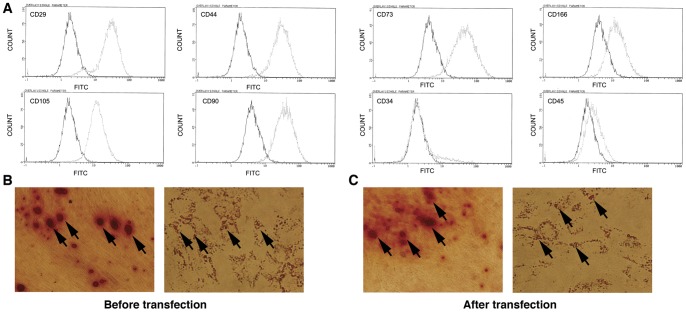
Analyze of the purified hpMSCs population.A. The phenotype characteristics of purified MSCs were verified by flow cytometry analysis, which showed that these expanded and plate-adhering populations of cells (at doublings 3 and 5) were positive for CD29 (>95%), CD44 (>95%), CD73 (>99%), CD90 (>95%), CD166 (>95%) and CD105 (>95%) surface marker expression and negative for CD34 (<3%) and CD45 (<3%). The solid line denotes unstained control cells and dotted line denotes isolated mesenchymal stem cells. B. Osteogenic and adipogenic differentiation determination in isolated mesenchymal stem cells. Left panel indicated positive calcium deposit (arrows), right panel indicated lipid vacuoles (arrows). C. Osteogenic and adipogenic differentiation determination in isolated mesenchymal stem cells after transfected with adenovirus. 48 h after transfection, cells were washed with PBS and cultured in OsteoDiff or Adipodiff induction medium for 3 weeks, then Oil-Red-O and Alizarin Red S were utilized to visualize calcium deposits and fat droplets separately. Lipid vacuoles and calcium deposits (arrows) could be visualized (×100).